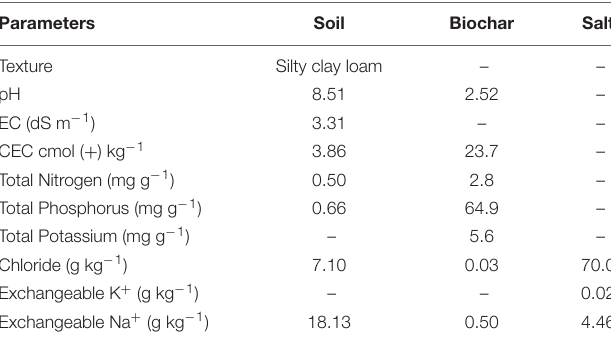
TABLE 1 | Physicochemical properties of soil, wood biochar, and salt used in experiment. Parameters